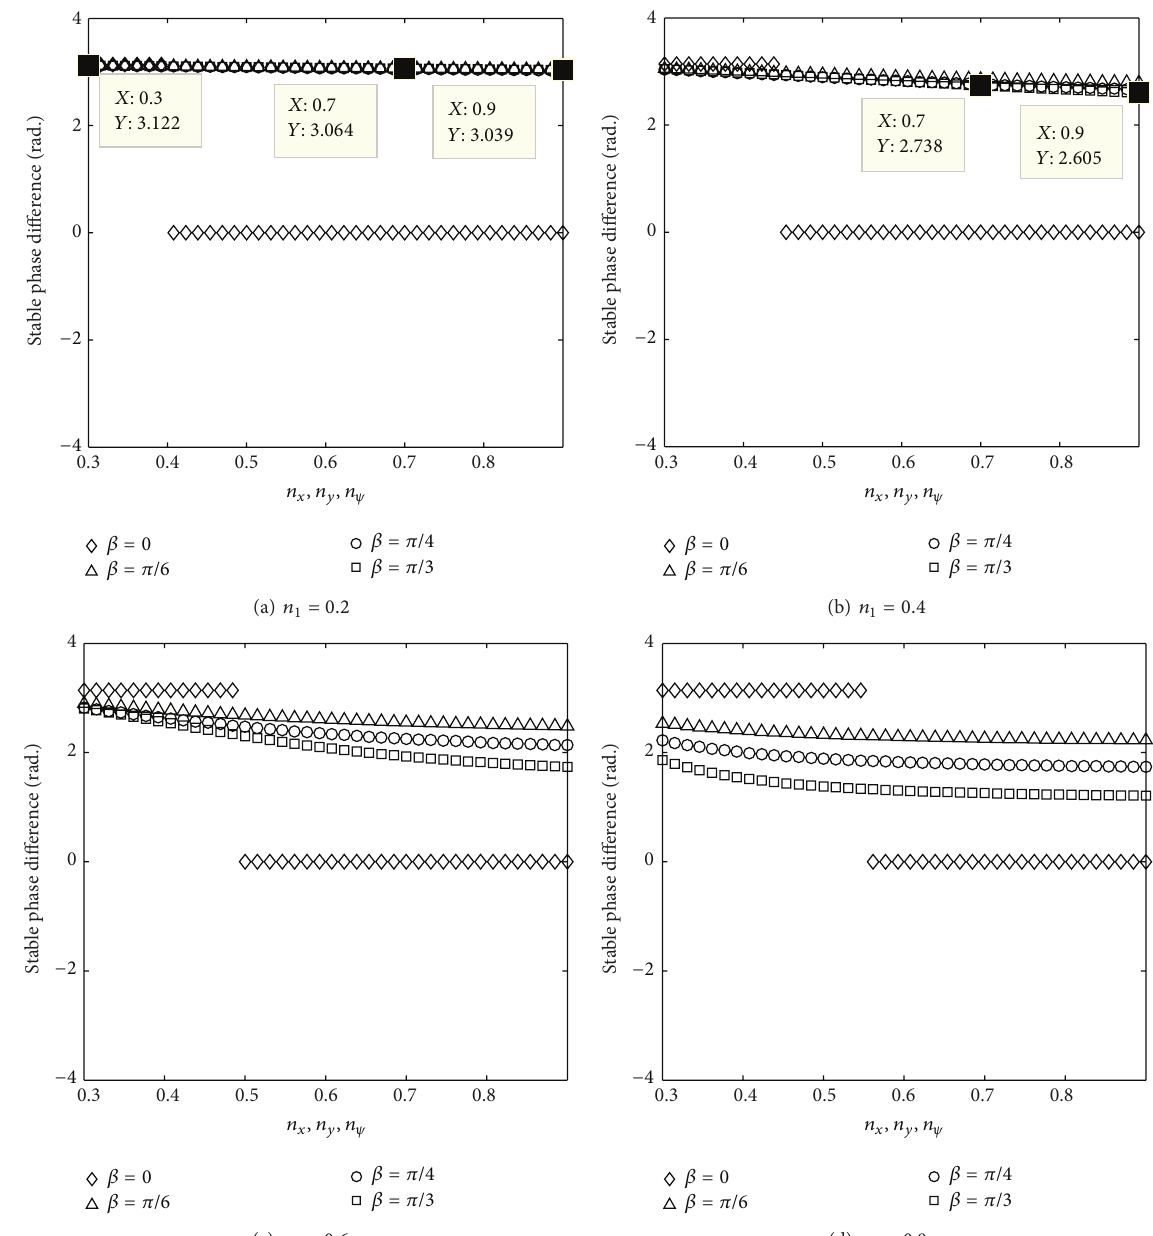
Figure 5: Stable phase difference for SACWB considering the variation of length 𝑙 of pendulum rod with 𝜂 13 = 5 , 𝜂 23 = 1 , 𝑛 𝑥 ≈ 𝑛 𝑦 ≈ 𝑛 𝜓 = 5.0 , = 0.08 , and 𝑙 = 0.3 : (a) 𝑛 = 0.2 , (b) 𝑛 = 0.4 , (c) 𝑛 = 0.6 , and (d) 𝑛 𝑟 𝑙 𝑒 1 1 1